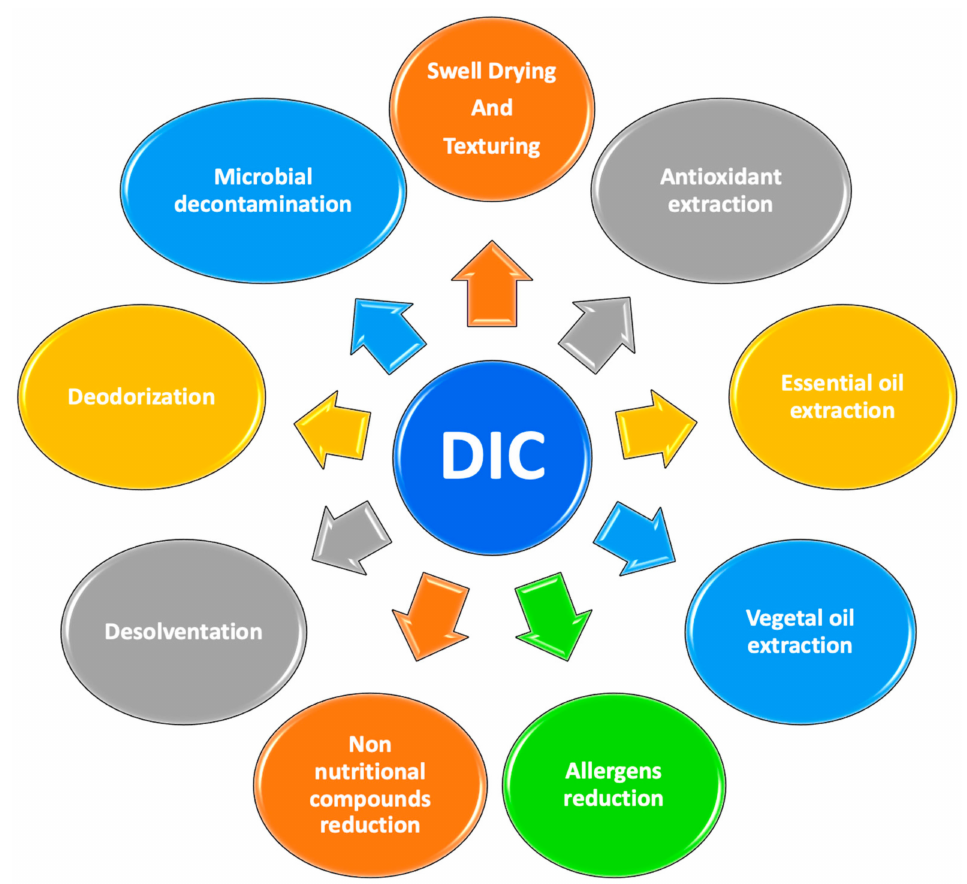
Figure 1. Main applications of the instant controlled pressure-drop DIC technology in food